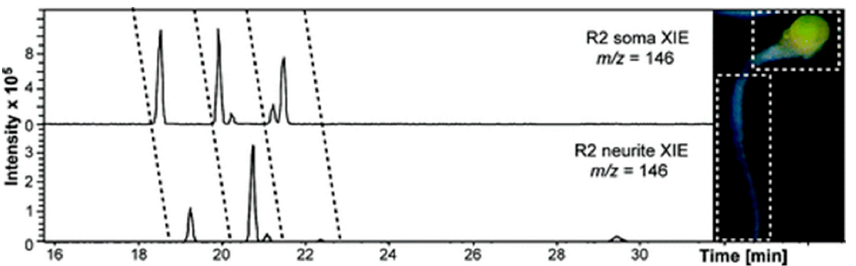
Figure 6. Different subcellular regions of the R2 neuron (neurite versus soma) yield different metabolite profiles. In this case, compounds with m / z 146 ± 0.5 Da are compared in the extracted ion electropherograms shown. Subcellular regions contain different relative amounts of several metabolites. Inset: Image of an isolated Aplysia californica R2 neuron and neurite. Reprinted with permission [48]. Copyright 2018 American Chemical Society.